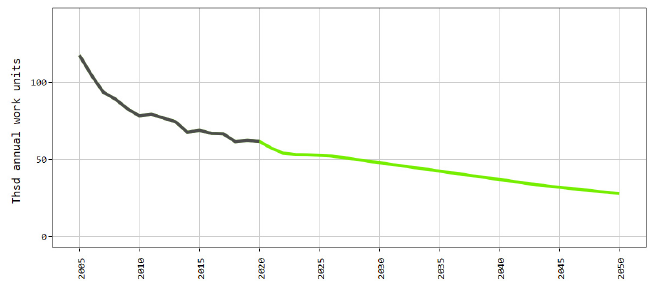
Figure 21. Number of persons employed in agriculture in 2005–2020, and a 2021–2050 projection for Latvia, thousands [62].